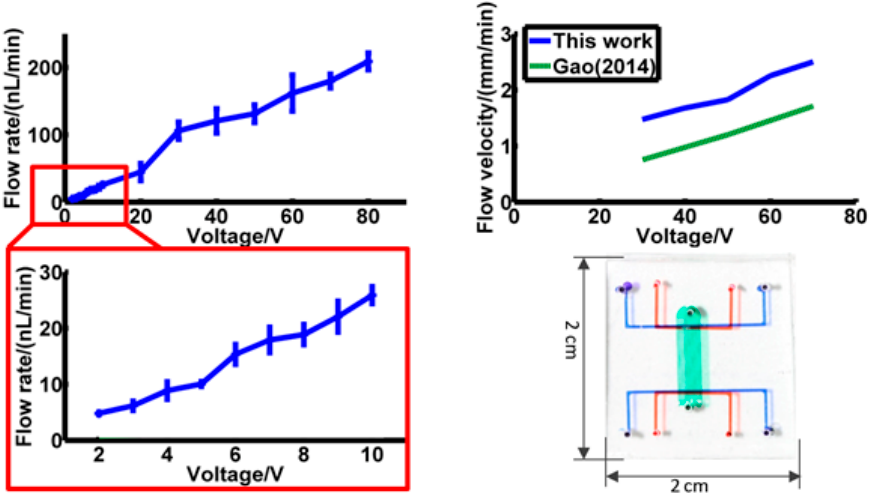
Figure 6. Flow rate at different voltage. ( a ) flow rate from 2 V to 80 V; ( b ) flow rate from 2 V to 10 V; ( c ) comparison of this work with Gao’s work [1] with similar dimensions; ( d ) size of this pump.